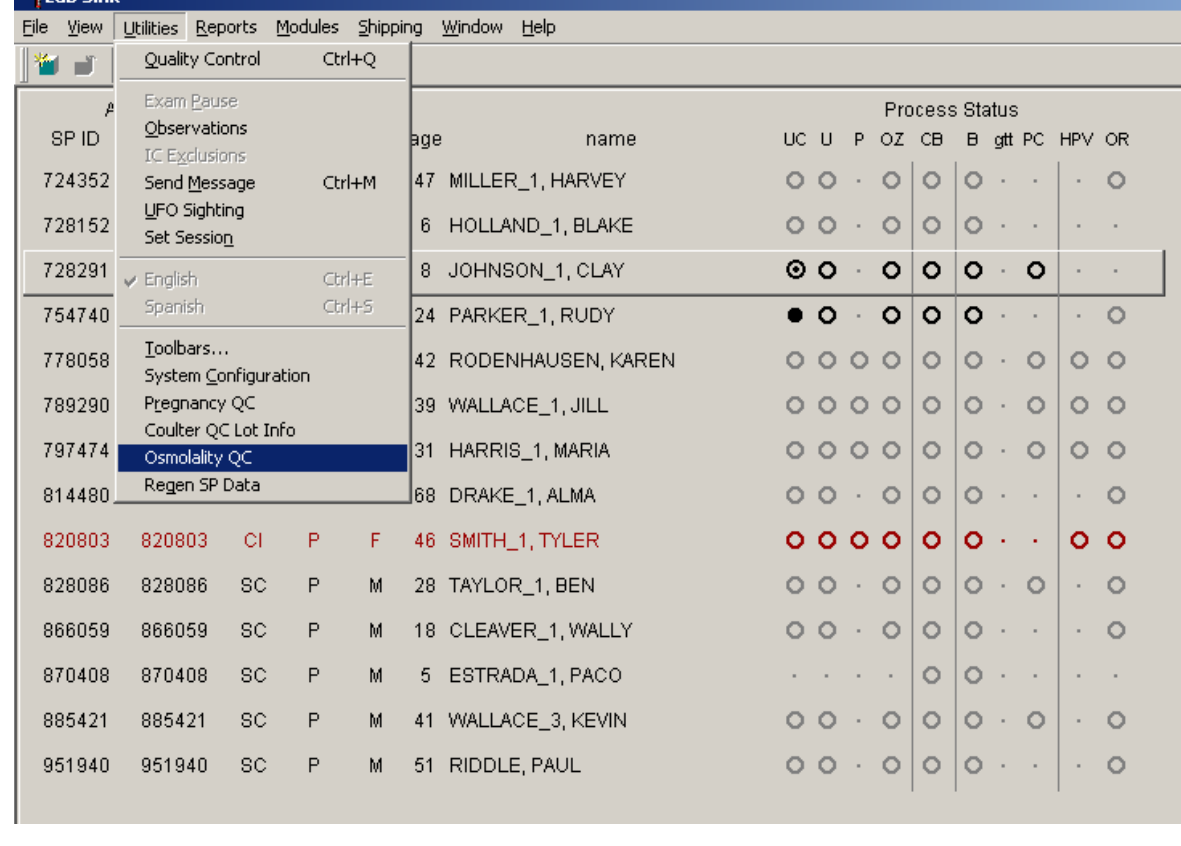
Direct the mouse arrow to the “Utilities” menu option near the top of the screen. Left click and drag the mouse down to “Osmolality QC” without releasing the left mouse button. Once “Osmolality QC”is highlighted, release the mouse